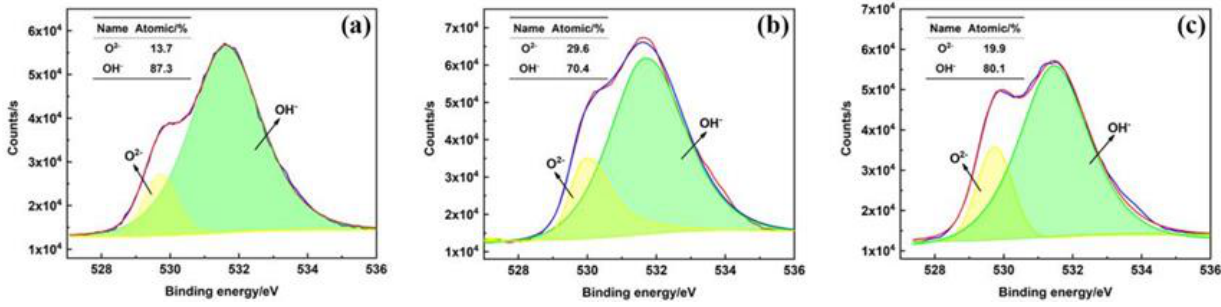
Figure 14. O2p peak fitting of 2205 DSS cladding layer under different current. ( a ) 90 A; ( b ) 100 A;